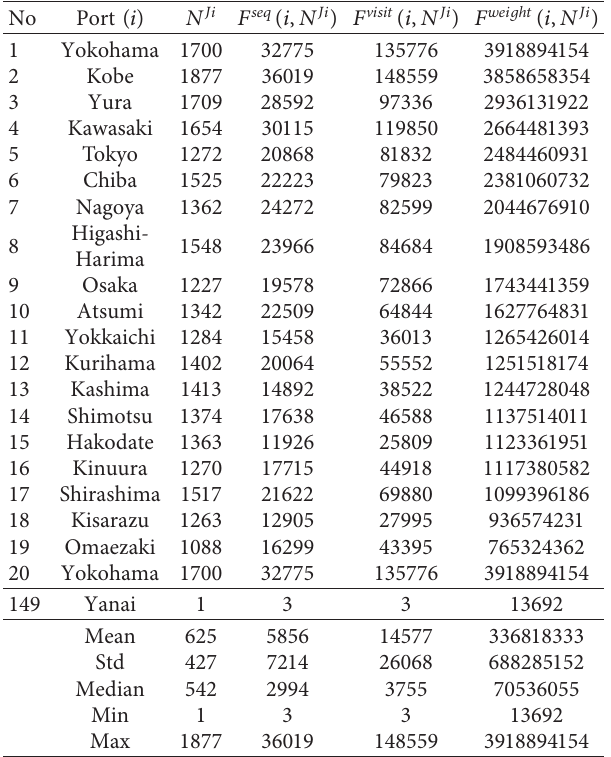
Table 5: International trading connections of Japanese